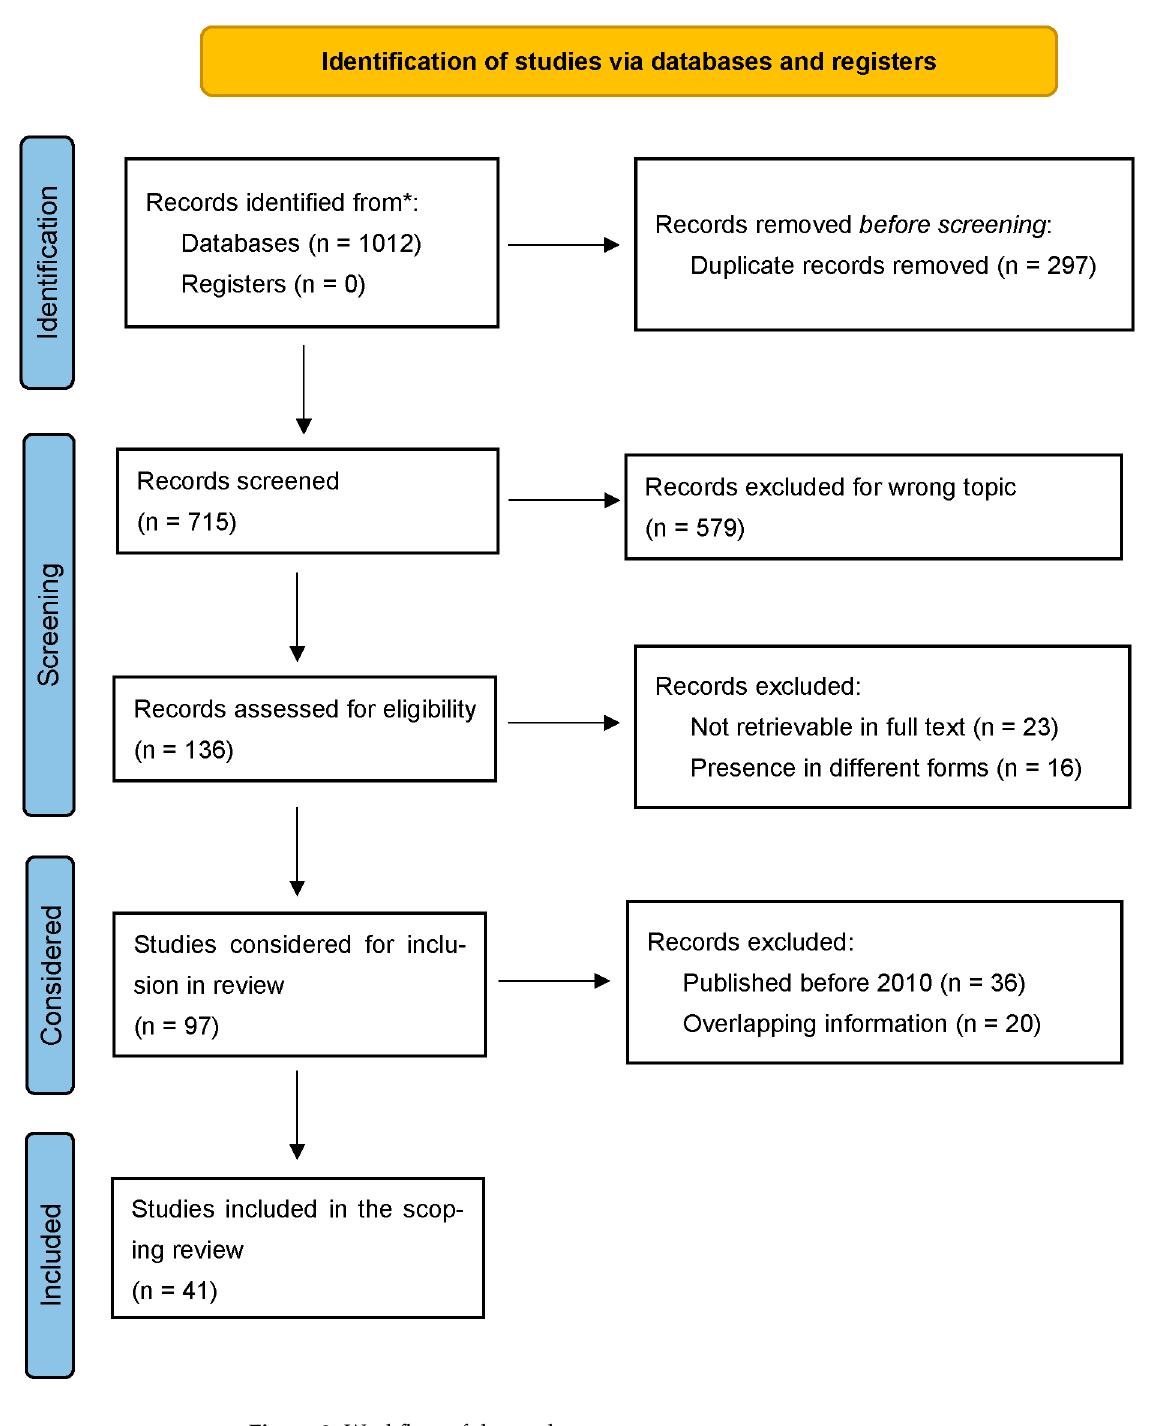
Figure 2. Workflow of the